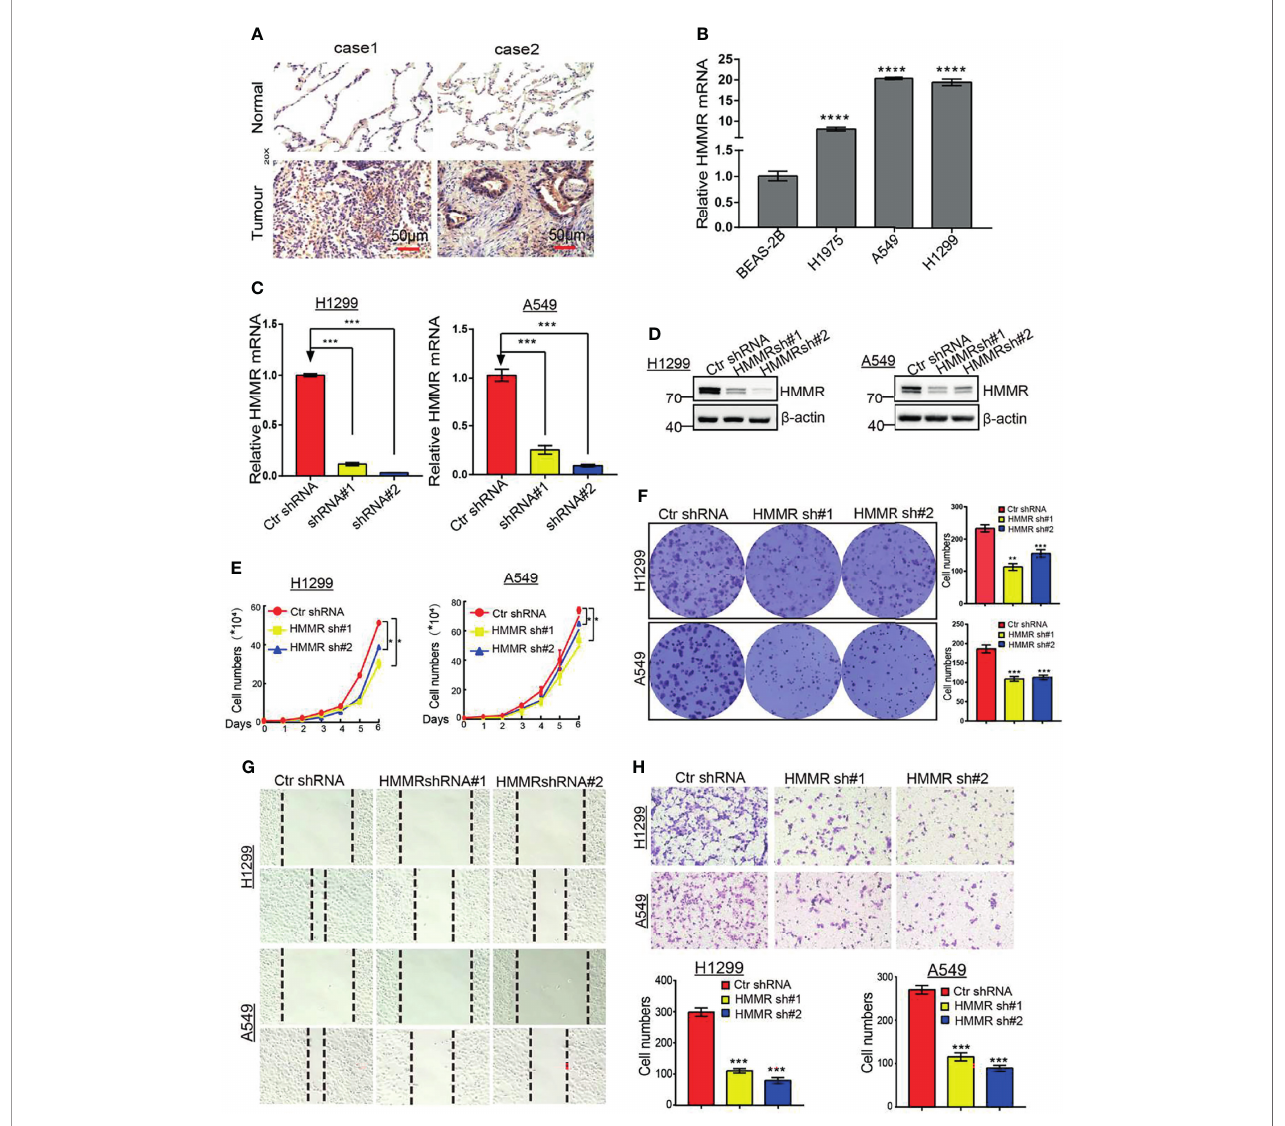
FIGURE 10 | Depletion of HMMR inhibits growth and migration of LUAD cells in vivro. (A) IHC analysis of HMMR in LUAD. (B) The expression of HMMR in LUAD cell lines by qRT-PCR. (C, D) Establishment of HMMR knockdown in A549 and H1299 cell lines and veri fi ed by qRT-PCR and Western blot. (E) The growth curve assay was employed detect the proliferation of LUAD cells. (F) The colony formation assay was employed detect the proliferation of LUAD cells. (G) The transwell assay was employed detect the migration of LUAD cells, (H) The wound healing assay was employed detect the migration of LUAD cells. P < 0.05 (*), P < 0.01 (**) and P < 0.001 (***), P < 0.0001 (***) was considered signi fi